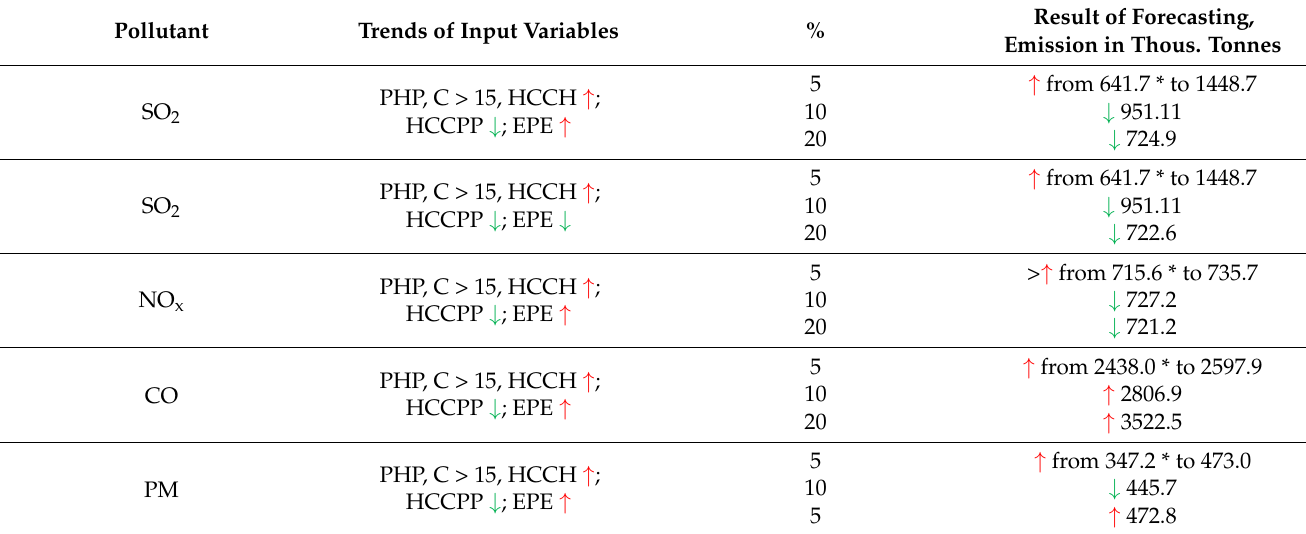
Table 4. The prediction